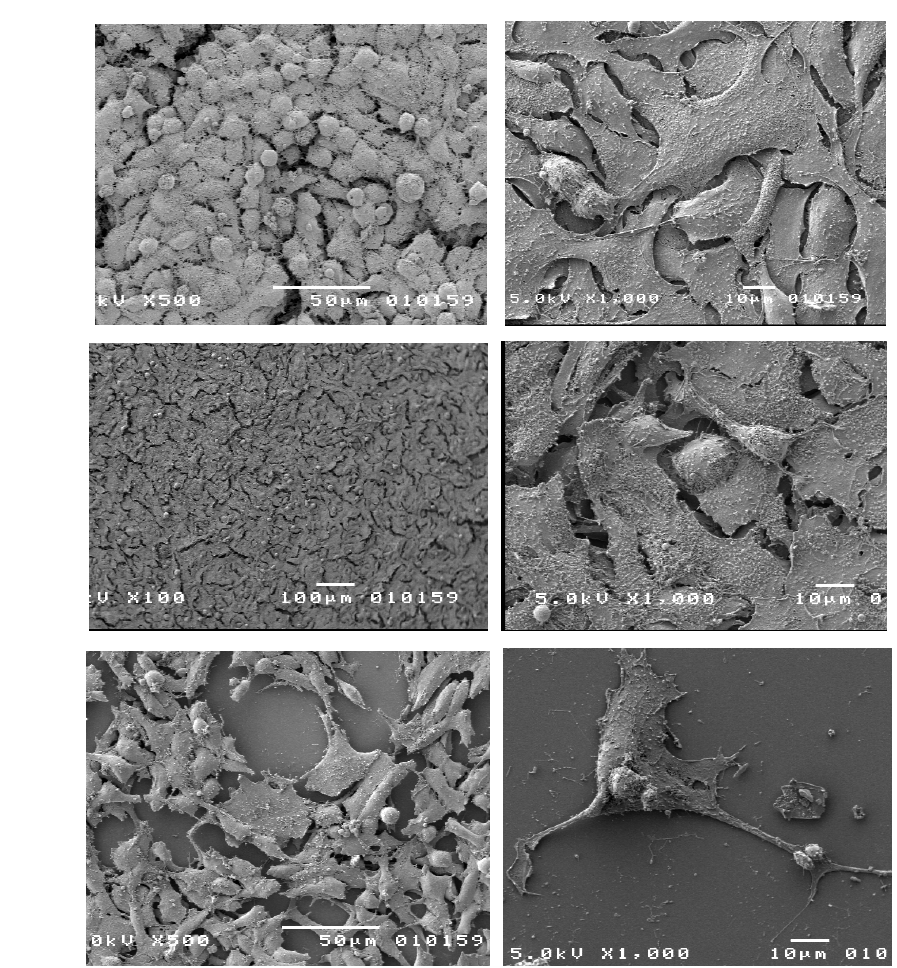
Figure 4. Growth of neuronal cell lines on Carbon. A: SKN-MC cells; B: SY5Y cells; C: P19